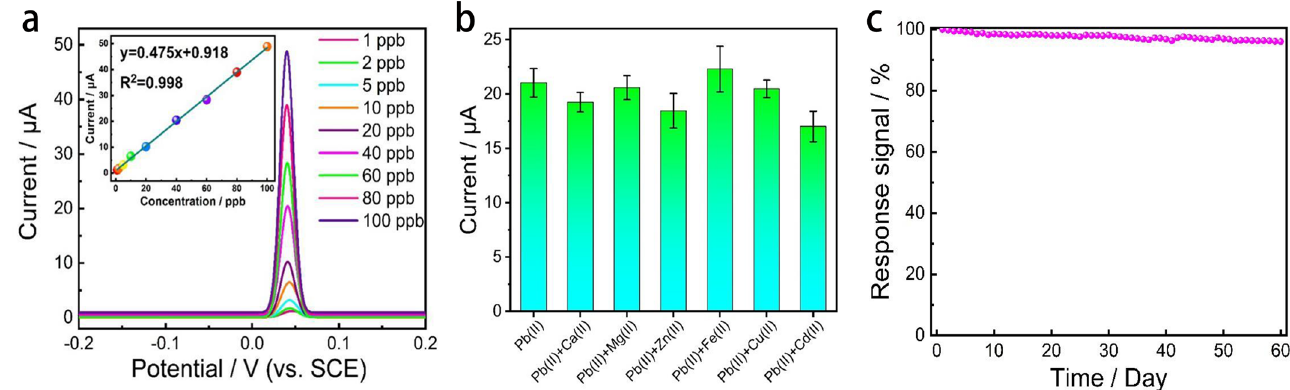
Figure 11. G/SBDD reproducibility, selectivity and thermoregulation. ( a ) Dissolution curves of Pb 2+ from nine replicate experiments on G/SBDD electrodes; ( b ) Effect of the six interfering ions on the Pb 2+ dissolution signal from the surface of the G/SBDD electrode; ( c ) Signal response of G/SBDD electrodes as a function of time.